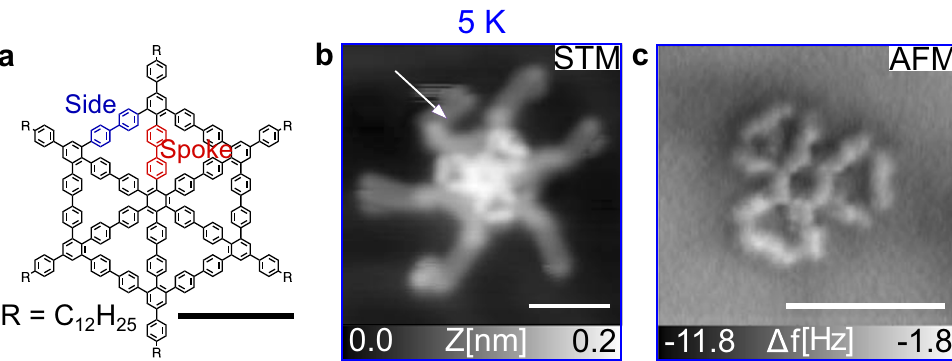
Fig. 1 Single spoked wheel molecules on Au(111). a Chemical structure of SW molecule equipped with dodecyl chains. b STM image of a single SW molecule on Au(111) ( I = 1 pA, U tip = − 380 mV). c Constant-height AFM image of the SW core acquired with a CO-terminated tip at 5 K. Scale bars: 2